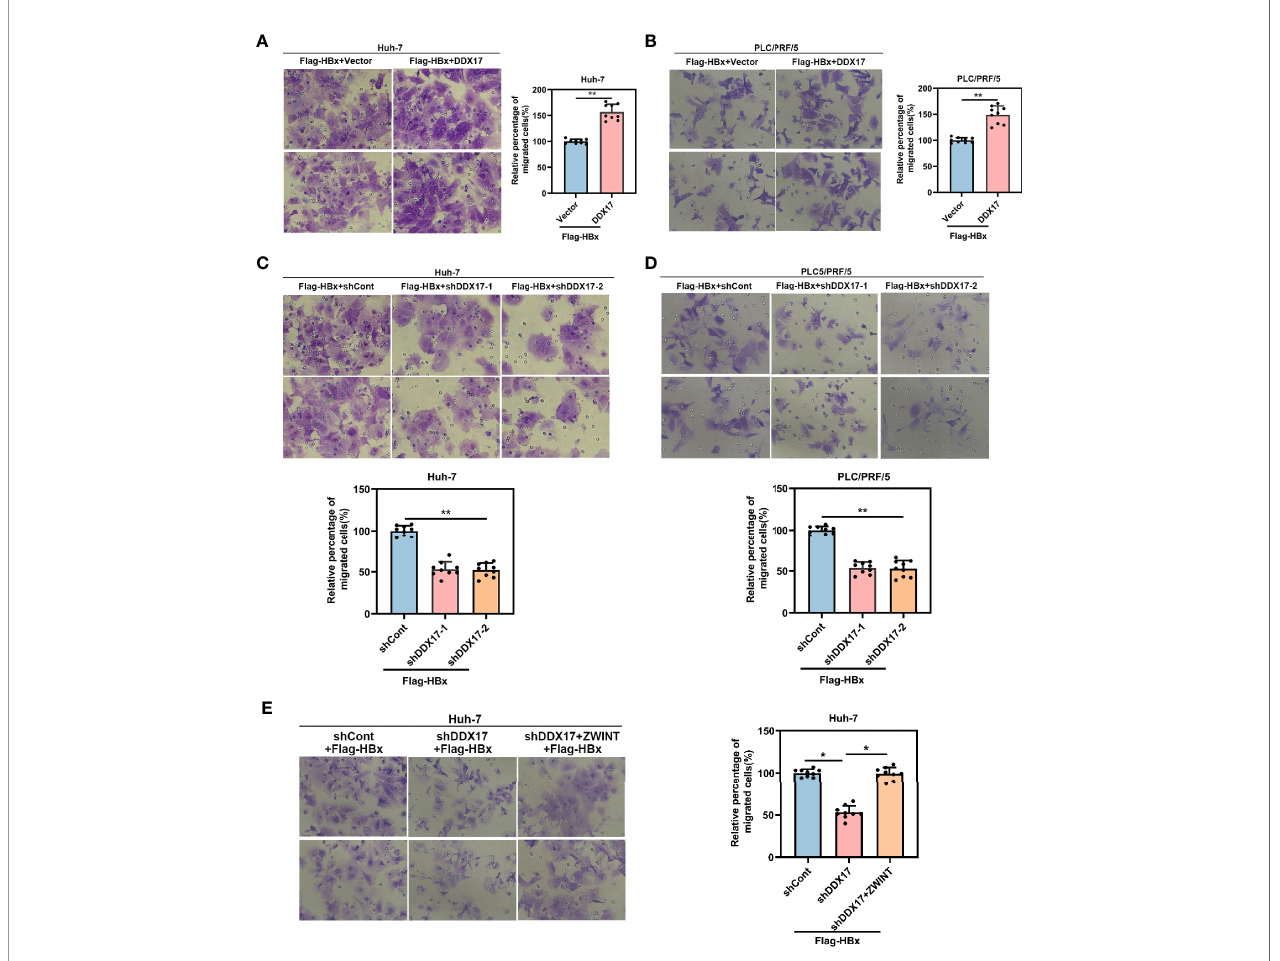
FIGURE 7 | DDX17 could facilitate HBx-mediated HCC migration. (A, B) Migratory ability was assessed by transwell assays in Huh-7 and PLC/PRF/5 cells with DDX17 overexpression. (C, D) Migratory ability was assessed by transwell assays in Huh-7 and PLC/PRF/5 cells with DDX17 knockout. (E) The effects of decreased DDX17 meanwhile upregulation of ZWINT in Huh-7 cells for migration analyzed by transwell assays. *P < 0.05, **P <